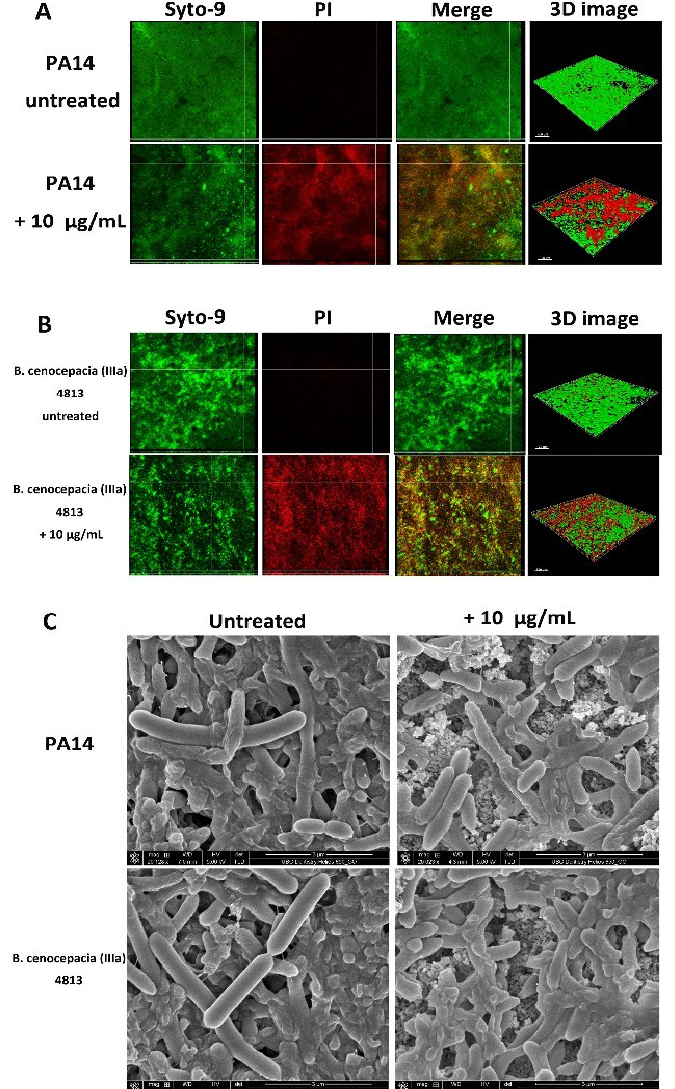
Figure 1. Sub-MIC concentrations of anti-biofilm peptide 1018 triggered biofilm cell death in the hydroxyapatite biofilm model. (A and B) Biofilms were stained using SYTO-9 to stain live cells green and propidium iodide (PI) to stain dead cells red. Merged images showing bacteria stained with both SYTO-9 and PI are also shown, and a yellow or red merged color was observed for dead cells. Samples were then examined using confocal laser scanning microscopy (CLSM). Each panel shows reconstructions from the top in the large panel and sides in the right and bottom panels (xy, yz, and xz dimensions). Three-dimensional reconstructions of biofilms are shown on the far right panel (3D image). The scale bar represents 100 µm in length. ( A ) P. aeruginosa PA14 untreated and treated with 10 µg/mL of peptide; ( B ) B. cenocepacia (IIIa) 4813 untreated and treated with peptide. Two independent experiments were performed for each condition; ( C ) SEM images showing the effect of peptide treatment on biofilm cells. P. aeruginosa and B. cenocepacia biofilms were developed on hydroxyapatite (HA) discs for 3 days and treated three times (every 24 h) with 10 µg/mL of peptide 1018. Biofilms were observed using SEM at a magnification of 20,000× operating at 5 kV. Untreated biofilms grown using the HA biofilm model were typically 30–40 μm thick, while biofilm thickness was reduced to 10–20 μm in peptide-treated